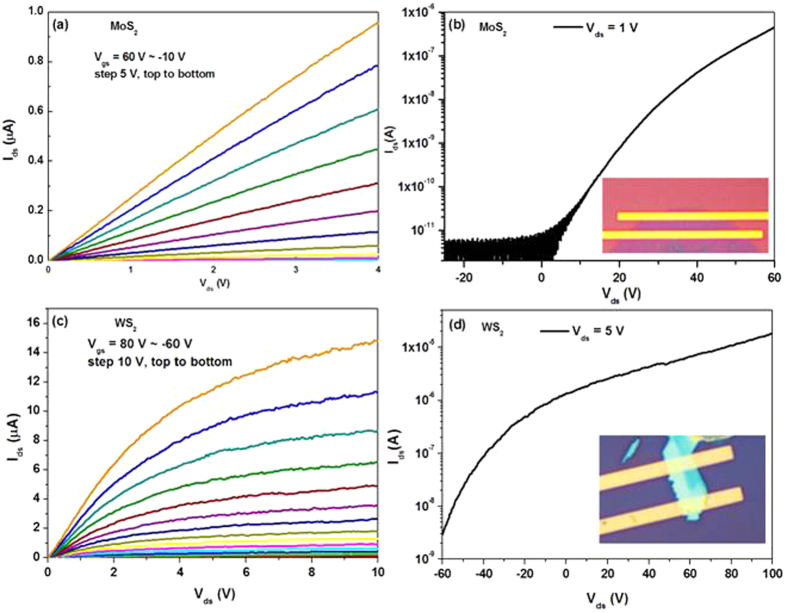
The electrical property of the measured MoS2 FETs (a,b) and WS2 FETs (c,d) The channel length and width are 2.82 μm and 24.5 μm for the MoS2 FETs, and 4.4 μm width and 4 μm length for the WS2 FETs.